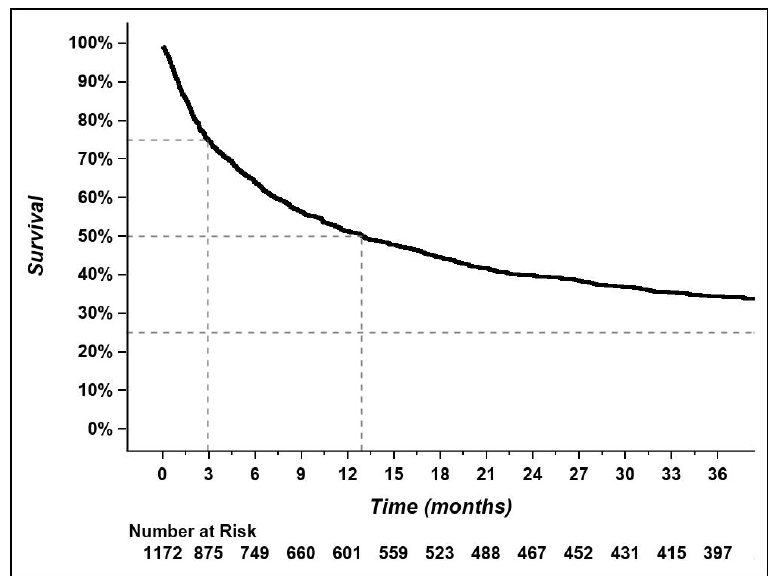
Figure 3. Overall survival for the whole cohort (n = 1172). Data cutoff date was 13 May 2020. Overall survival was defined as the time from diagnosis to death. Table 3. Wait times and overall survival.